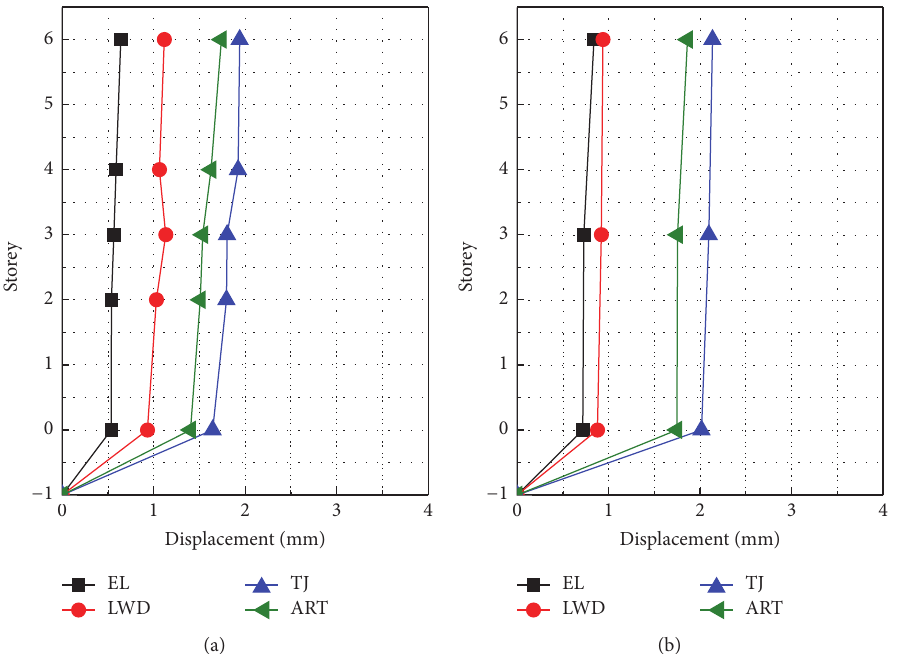
Figure 21: Profiles of maximum storey displacements of isolated structure under minor earthquakes: (a) direction x ; (b) direction y .